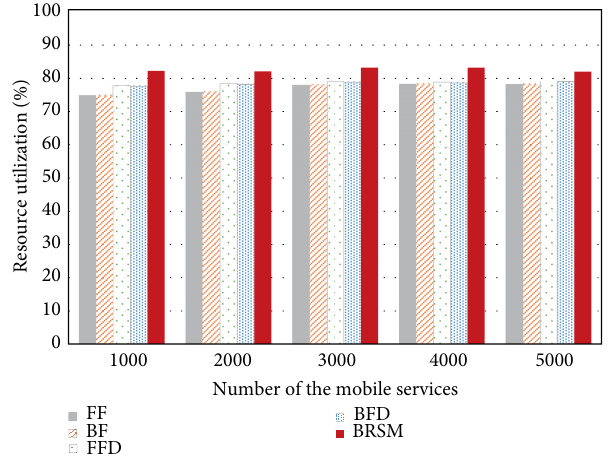
Figure 7: Comparison of the average resource utilization of edge servers by FF, BF, FFD, BFD and BRSM.